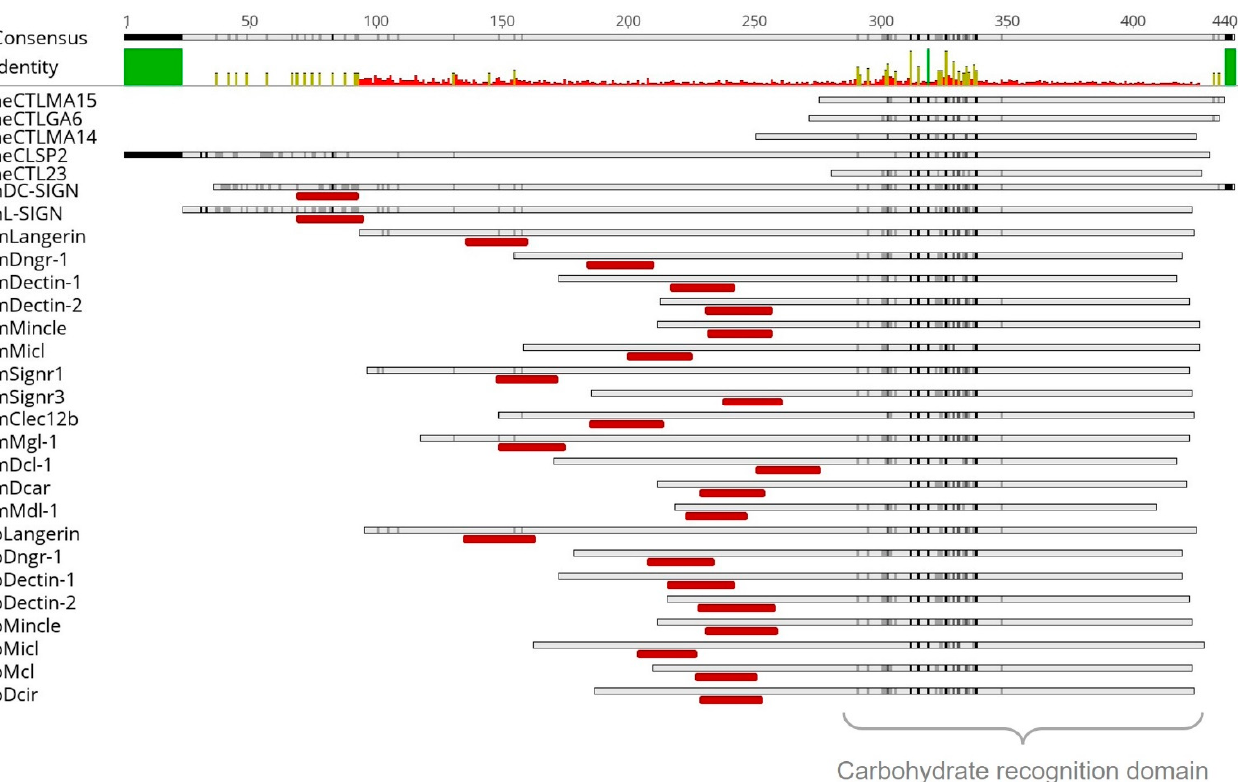
Figure 1. Alignment of 28 C-type lectin receptor amino acid sequences (ae: Aedes aegypti , h: Homo sapiens sapiens , m: Mus musculus , o: Ovis aries) . Amino acids similarity analysed with Score Matrix Blossum62 (Threshold 1) and symbolised in light grey (60–79% similarity), dark grey (80–99%), and black (100%). Hydrophobic part, indicating a transmembrane region, marked in dark red below the sequence. Above, consensus and mean pairwise identity over all amino acid sequences shown (green: 100% identity; yellow: 30–99%; red: <30%). Mosquito amino acid sequences were obtained from VectorBase and mammalian sequences from NCBI (Tables 1 and 2). Sequence analysis was performed, and figures were prepared using the Geneious Prime software.